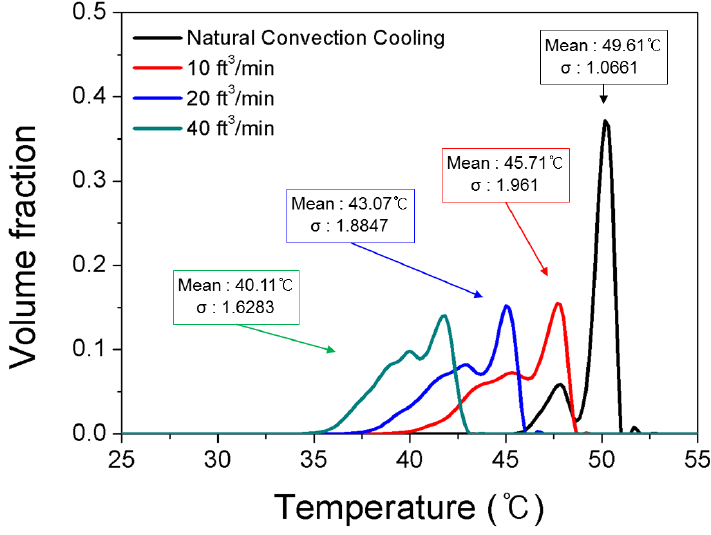
Figure 13. Distributions of the volume fraction of the LIB cells within the module as a function of temperature at the discharge time of 960 s with the discharge rate of 3 C for various cooling